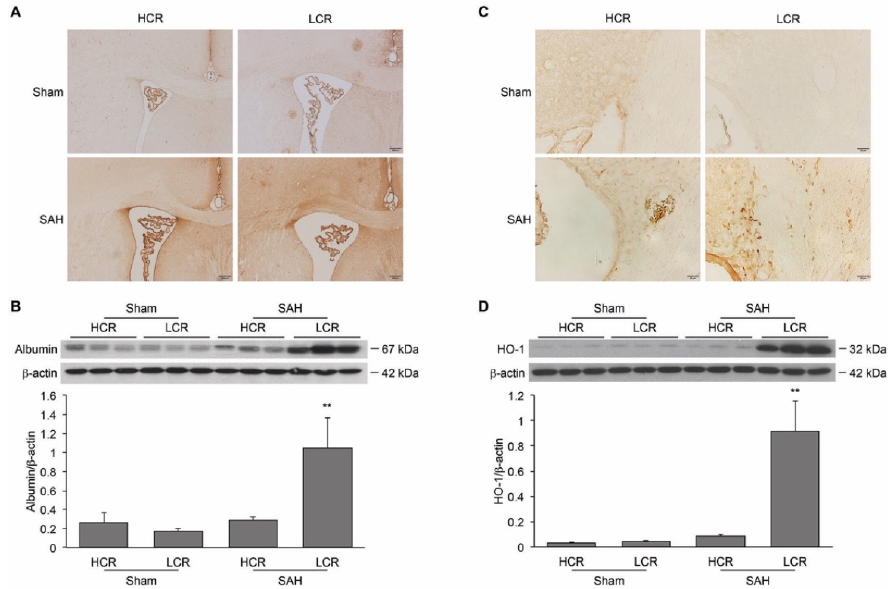
Figure 3. SAH induced greater BBB breakdown and more HO-1 upregulation 24 h after SAH in LCR rats than in HCR rats. ( A ) Representative images of periventricular albumin immunohistochemistry in LCR and HCR rats after SAH or a sham operation. Albumin-positive staining is indicated by the darker color in brown intensity. Scale bar = 200 μ m. ( B ) Albumin levels were quantified by Western blotting. Values are mean ± SD; ** p < 0.01 LCR + SAH versus HCR + SAH. ( C ) Representative images of periventricular HO-1 immunohistochemistry in LCR and HCR rats after SAH or a sham operation. Scale bar = 20 μ m. ( D ) HO-1 levels were quantified by Western blotting. Values are mean ± SD; ** p < 0.01 LCR + SAH versus HCR + SAH. CD163 is a hemoglobin scavenger receptor. No CD163 positive cells were detected in